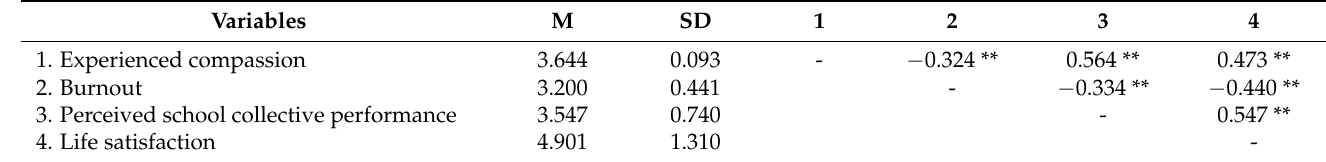
Table 1. Correlations among study variables.